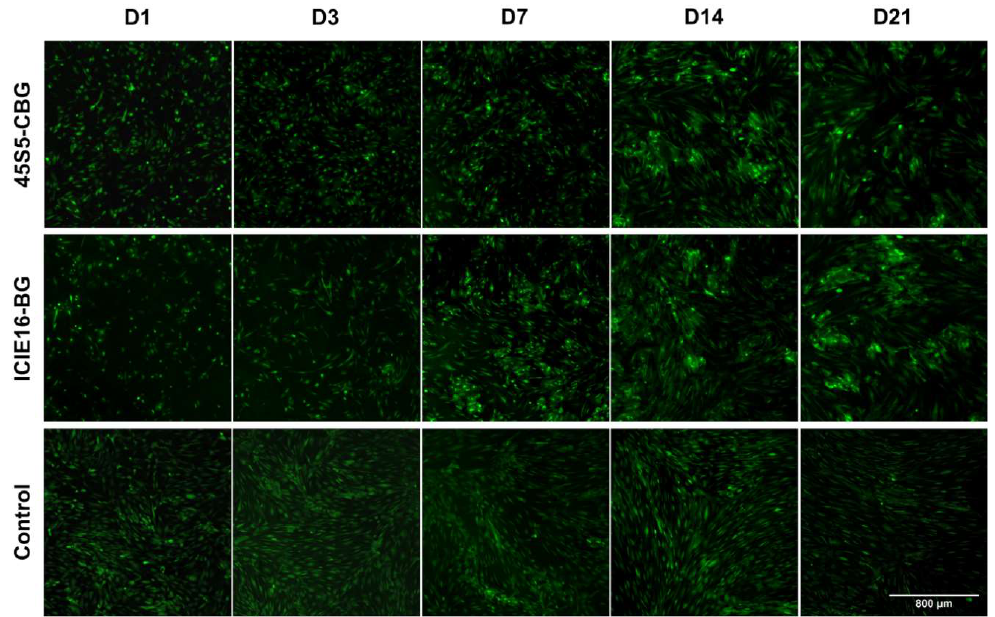
Figure 2. Microscopic visualization of cell viability and growth patterns. Magnification: 40-fold; reference bar refers to 800 µ